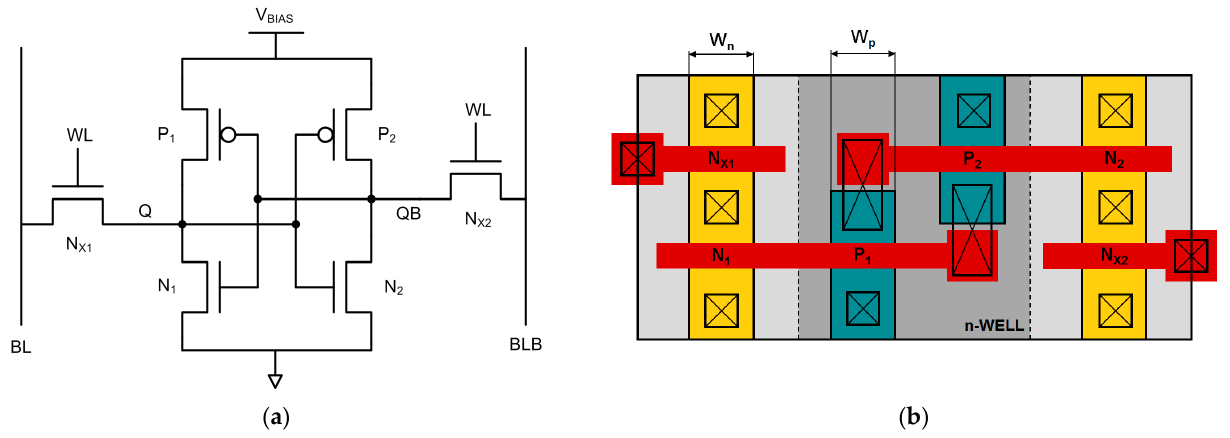
Figure 1. ( a ) Schematic of the six-transistor SRAM cell (6T cell) ( b ) Layout of the 6T cell without metal lines.